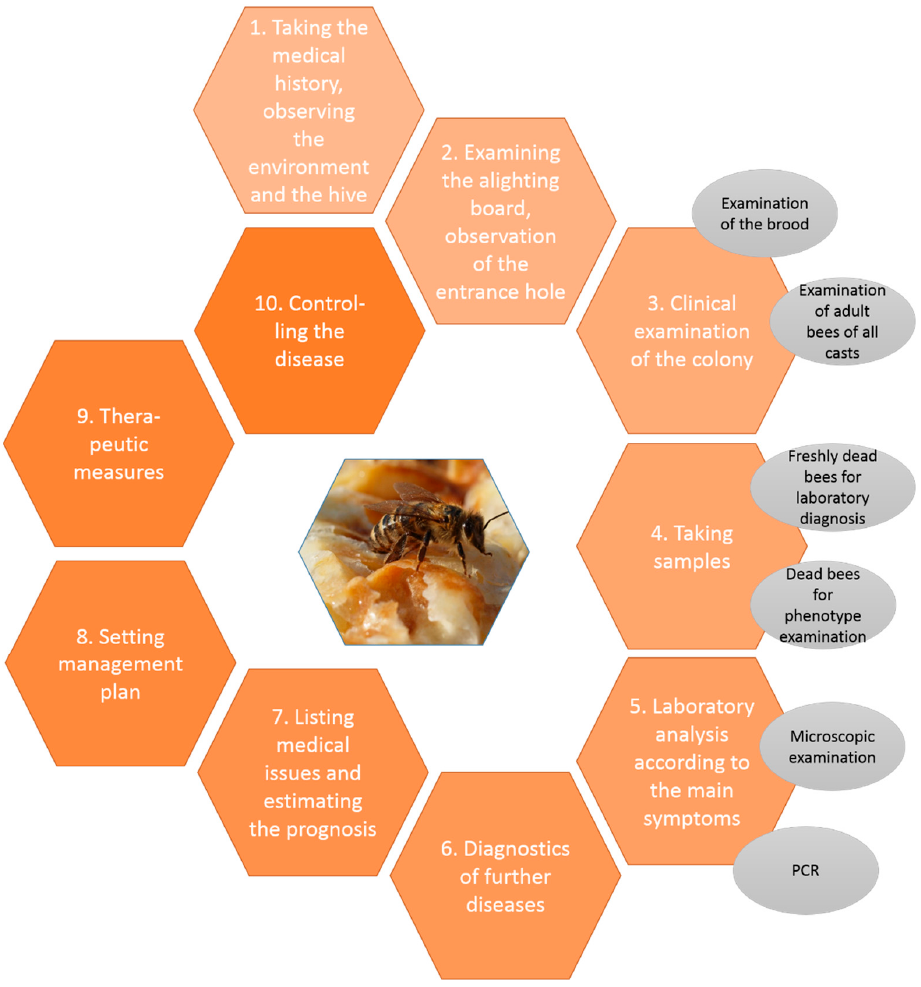
Figure 1. Diagnostic approach in bee diseases, © Julia Dittes.